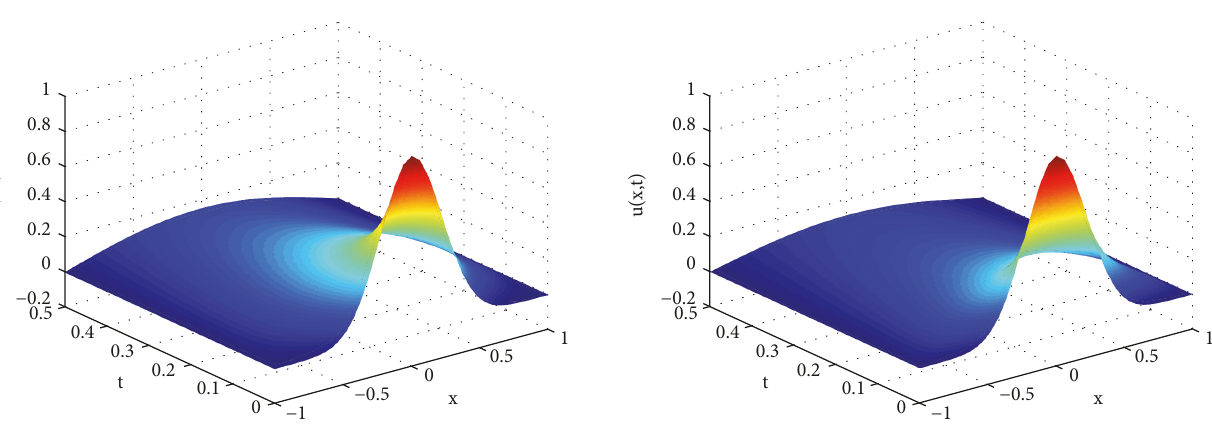
Figure 7: Standard Brownian motion: 𝛼 = 1, 𝛽 = 1 .